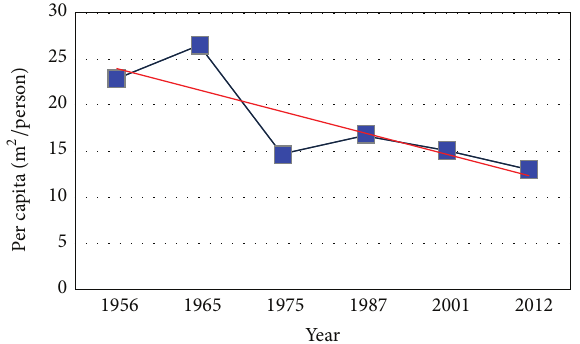
Figure 5: Per capita changes of built-up areas during